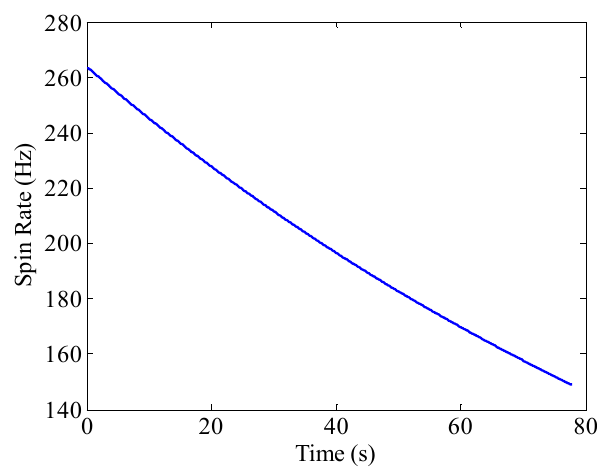
Figure 12. The theoretical spin rate of projectile in ballistic flight.